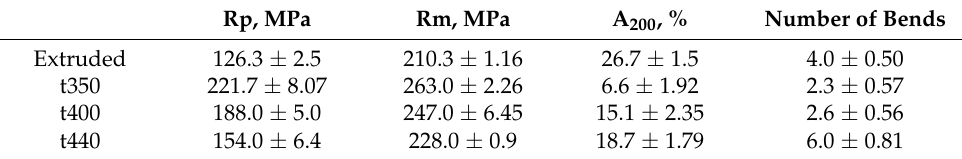
Table 3. Mechanical properties of the material after extrusion and hot drawing.